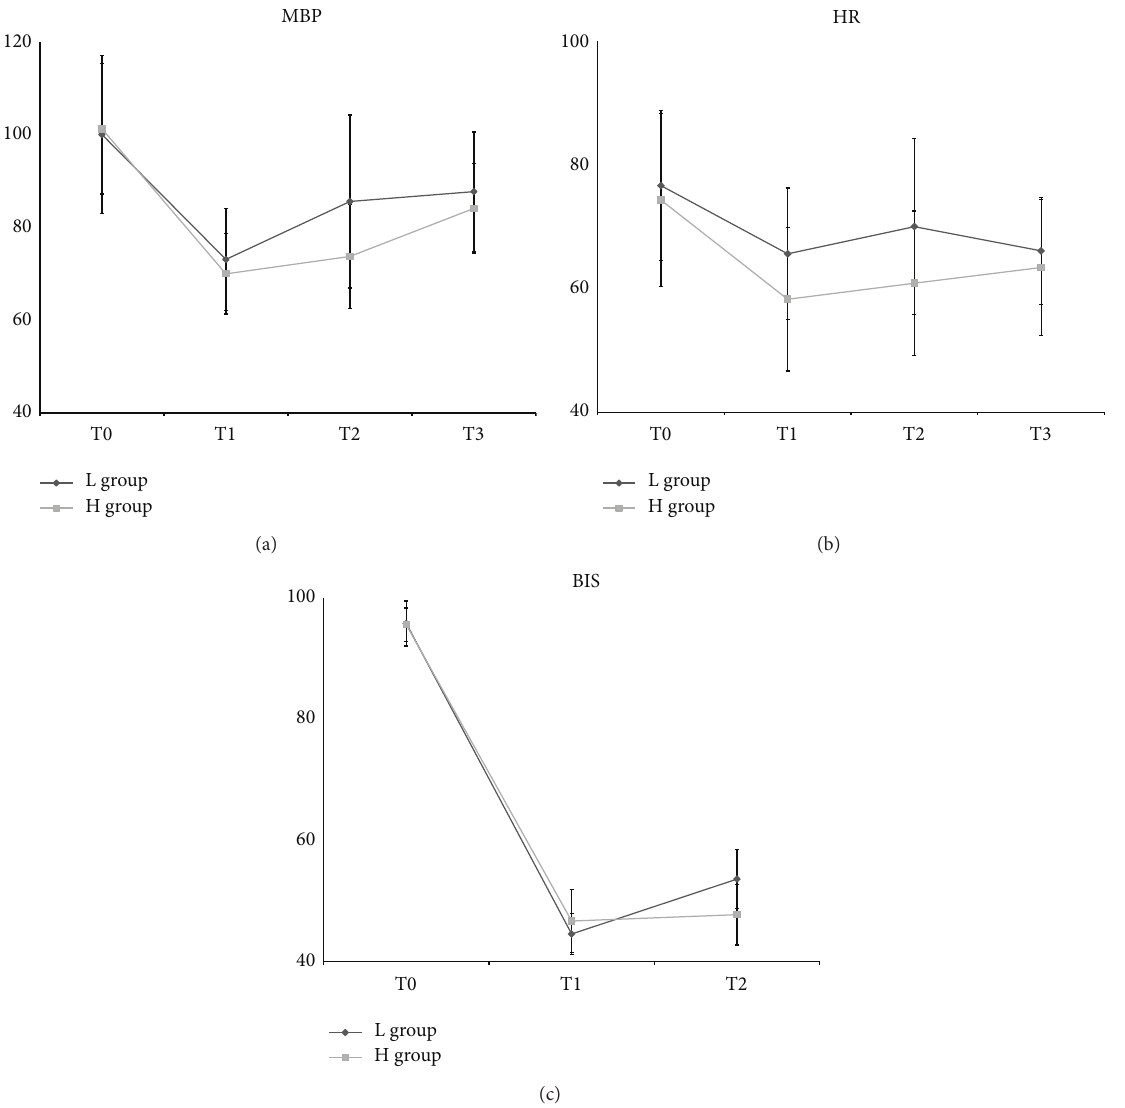
Figure 2: Haemodynamic changes according to time. (a) MBP: systemic mean blood pressure. (b) HR: heart rate. (c) BIS: bispectral index. L